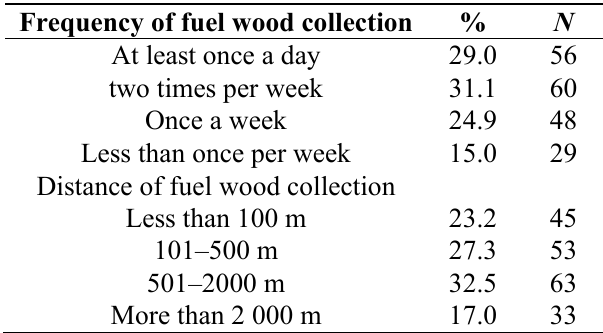
Table 4. Frequency and distance of fuel wood